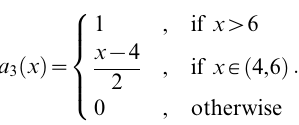
Figure 2. Stable-like processes with a ( x ) : ~ 1 z exponent. In the yellow regions it behaves almost like Brownian motion, in the red regions it behaves almost like a Cauchy process.